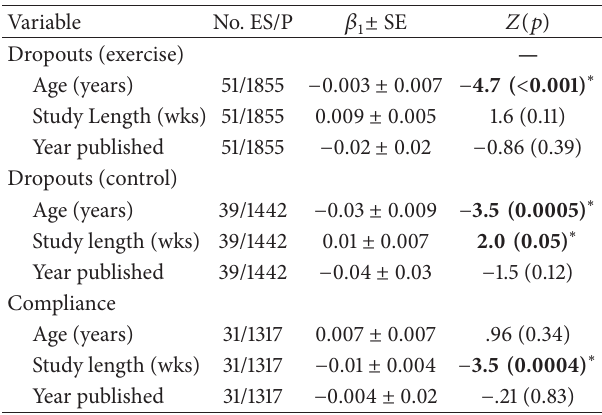
Table 3: Meta regression results for dropouts and